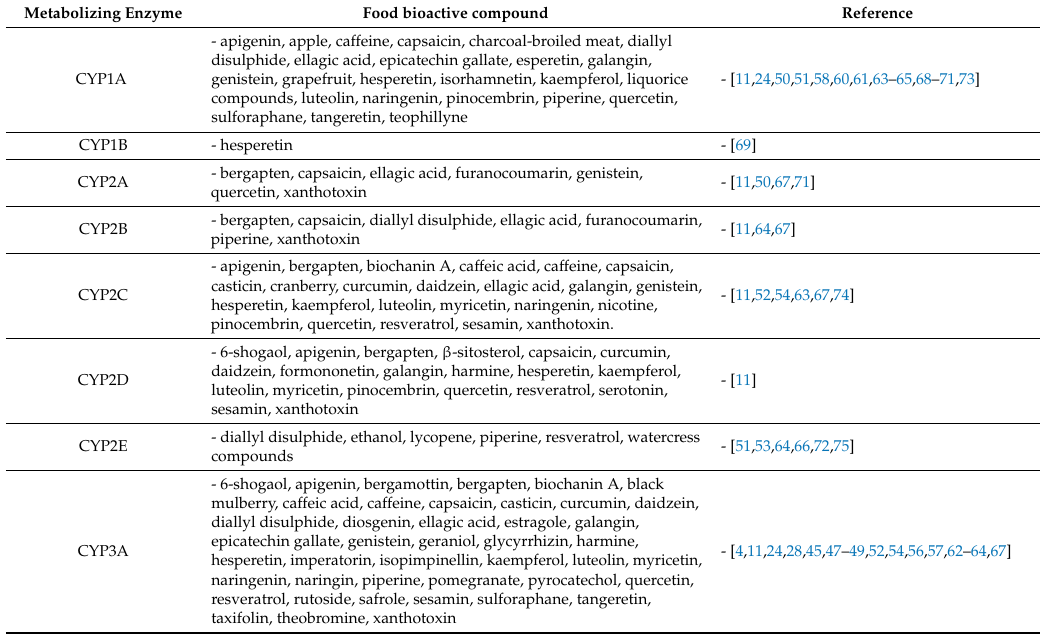
Table 3. Enteric and hepatic metabolizing enzymes of phase I that are targeted by food bioactive